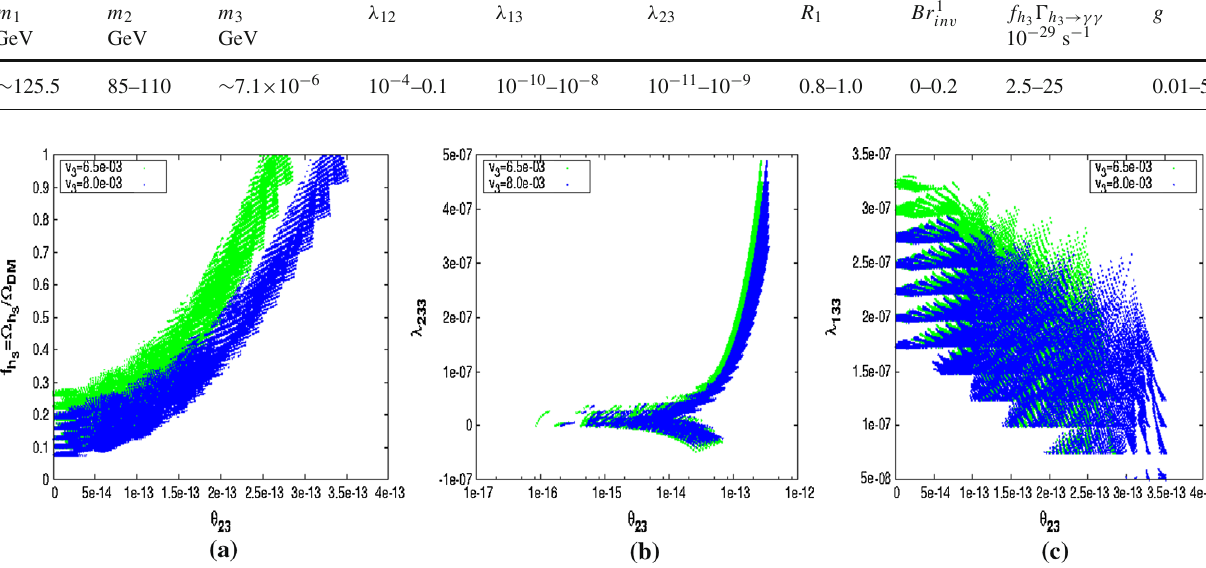
Table 1 Constraints and chosen region of model parameters space for the two component dark matter model